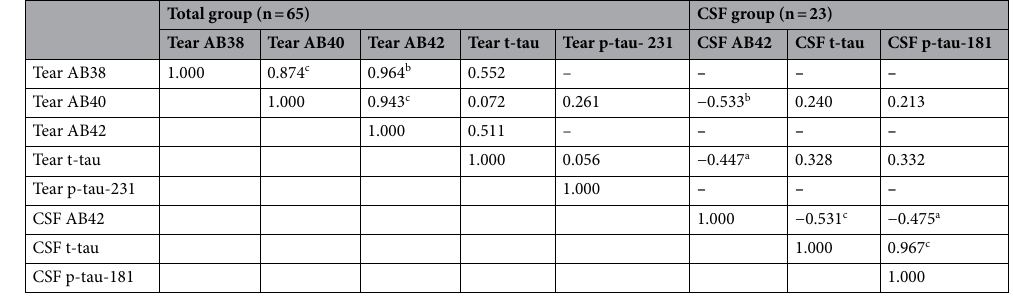
Table 4. Correlations of biomarkers within the total study population (left) and the CSF group (right). Data are presented as Spearman rank correlation coefficient (r). Correlations with n < 10 pairs were omitted. AB amyloid beta, CSF cerebrospinal fluid, t-tau total tau, p-tau-231 tau phosphorylated at threonine 231, p-tau- 181 tau phosphorylated at threonine 181. a p < 0.05, b p < 0.01, c p <